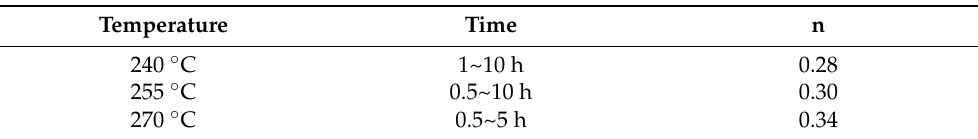
Figure 10. The plot of ln t vs. ln d of Cu 6 Sn 5 phase at different reaction temperatures in the SC/Alloy 25 reaction couple. Table 4. The n values of Cu 6 Sn 5 phase at different reaction temperatures in the SC/Alloy25 reaction couple.